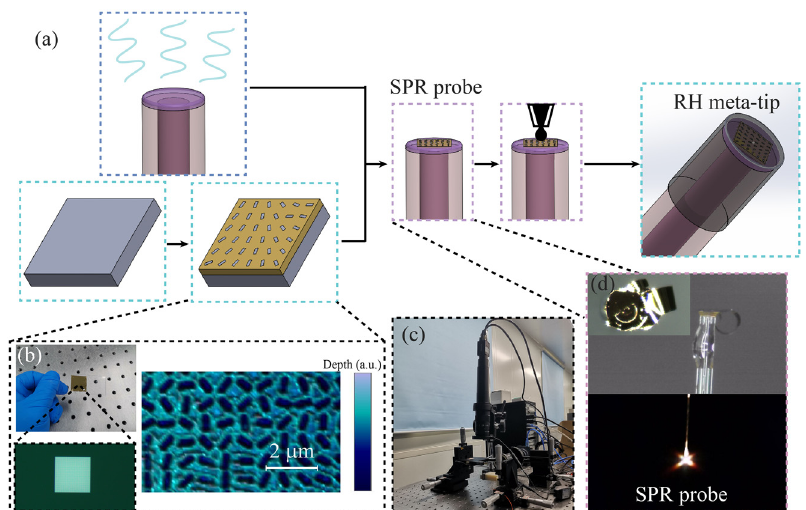
Figure 2: (a) Schematic diagram of the fabrication process of RH meta-tip. (b) Optical microscope image (left) and atomic force microscope (AFM) image (right) of the metallic metasurface. (c) Experimental system for MMF core and metasurface alignment. (d) Optical images of SPR probe